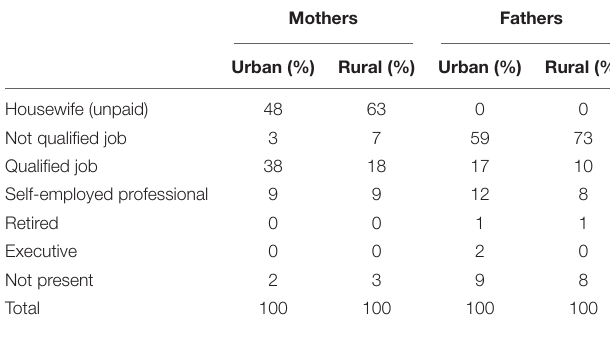
TABLE 3 | Type of occupation parents in urban and rural areas have